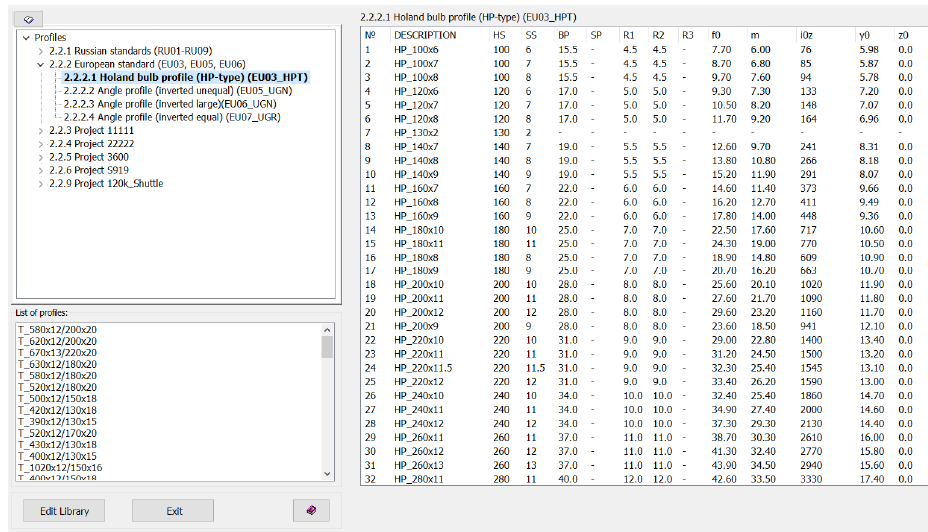
Figure 17. Ship load cases.